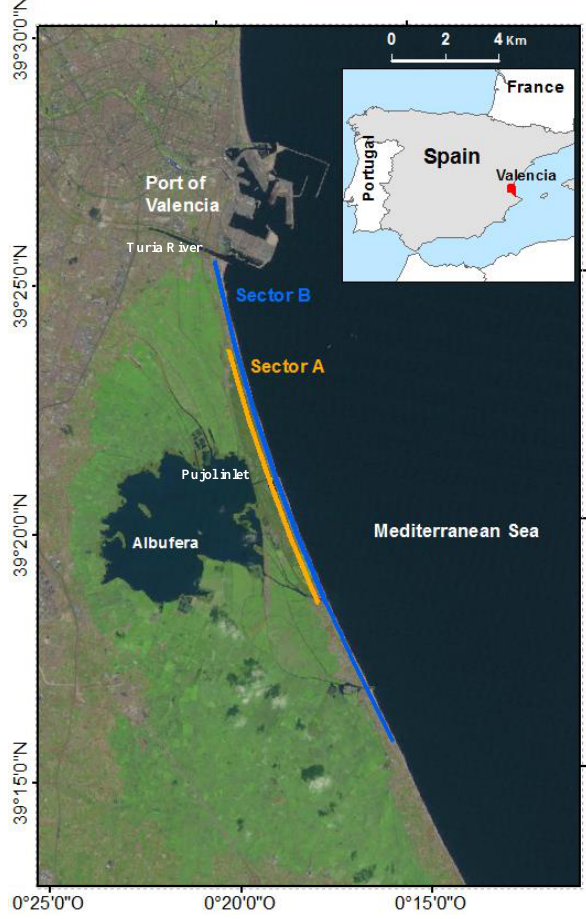
Figure 1. Location map of the two coastal sectors in the Valencian coast.